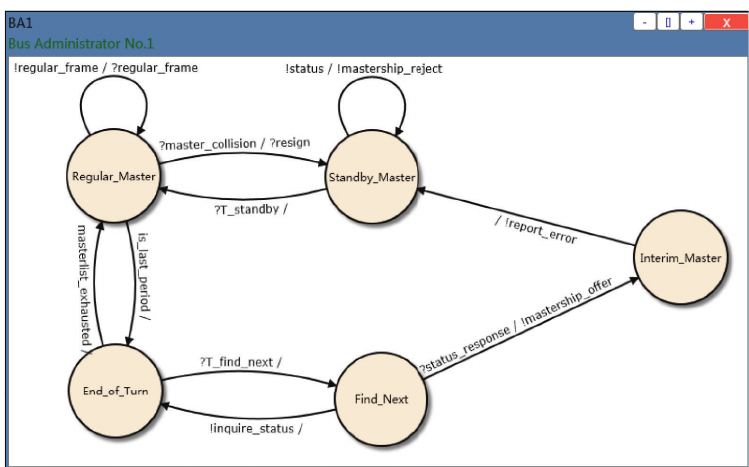
Figure 12: Model of a BusAdmin constructed in M 3